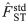
Evaluation of FST estimators.The Weir-Cockerham, Weir-Hill, Weir-Goudet (for individuals), HudsonK (equal to Weir-Goudet for subpopulations, S1 Text), BayeScan, F^STstd in Eq (25) derived from the standard kinship estimator, and our new FST estimator in Eqs (34) and (37), are evaluated on simulated genotypes from our two models (Fig 2). The Weir-Cockerham FIT estimator was also included to show that estimation of total inbreeding behaves similarly to FST estimators. (A) The independent subpopulations model required by the Weir-Hill, HudsonK, and BayeScan FST estimators. All but standard kinship (F^STstd) and Weir-Goudet (for individuals) recover the target FST IBD probability in Eq (9) (red line) with small errors. (B) Our admixture scenario, which has no independent subpopulations, was constructed so F^STstd≈12FST. Only our new estimates are accurate. The rest of these estimators give values smaller than the target FST IBD probability, which result from treating kinship as zero between every subpopulations imposed by geographic clustering (or between individuals for Standard Kinship and Weir-Goudet). The F^STindep estimator limit in Eq (14) (green dotted line) overlaps the true FST (red line) in (A) but not (B). Estimates (blue) include 95% prediction intervals (often too narrow to see) from 39 independently-simulated genotype matrices for each model (Methods, section Prediction intervals).